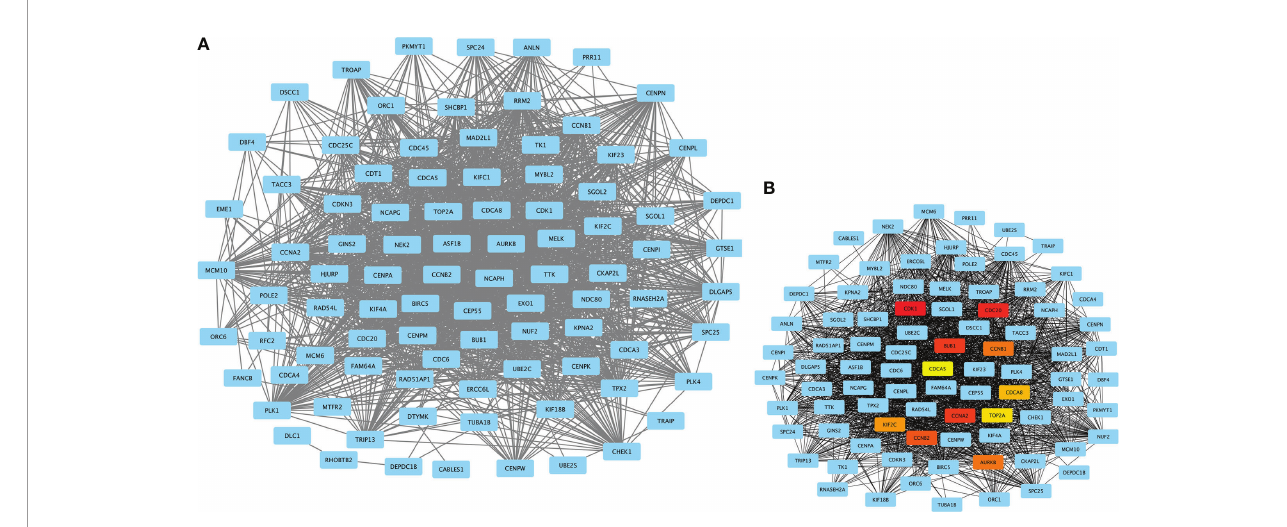
FIGURE 10 | PPI network constructed by MECOM and PRDM16 intersection coexpression genes. (A) PPI network. (B) Ten hub genes in the PPI network. The top 10 hub genes are shown in different colors except blue. MECOM, MDS1 and EVI1 complex locus, also called PRDM3; PRDM16, PR domain containing 16, also called MEL1; LUAD, lung